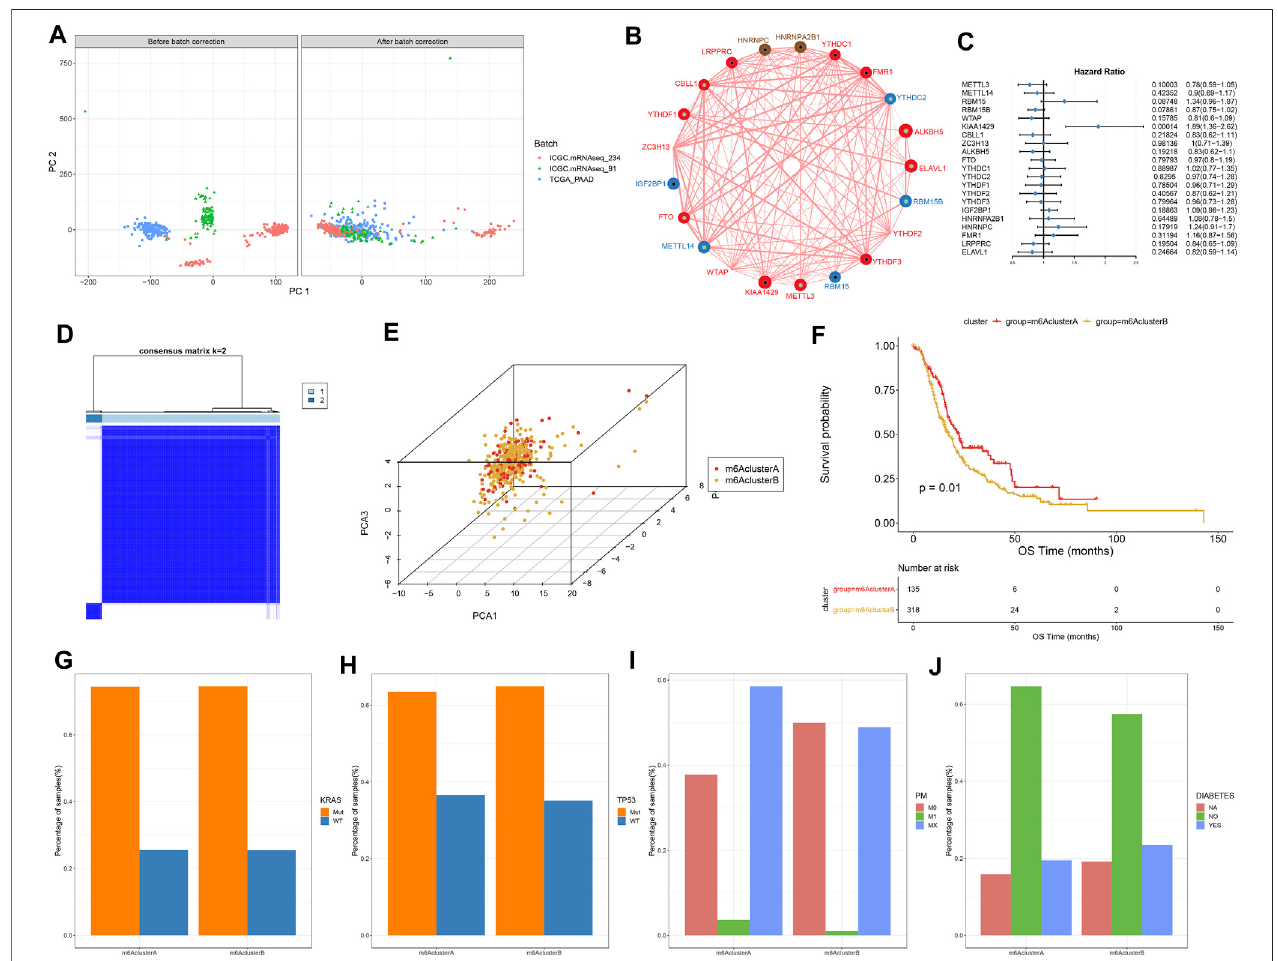
FIGURE 2 | Construction of two m 6 A methylation modi fi cation patterns in pancreatic cancer from TCGA and ICGC datasets. (A) PCA plots showing before and after batch correction ofTCGAand ICGC datasets. (B) An interaction networkof m 6 Aregulators. The sizeofthe circle indicates the impactof each regulatoronsurvival, andthelargerthecircle,themorerelevantitsexpressionistotheprognosis.Thegreendotinthecircleindicatesthattheregulatorisaprotectivefactorforprognosis,and the black dot in the circle indicates that the regulator is a risk factor for prognosis. The lines connecting regulators indicate their interactions, negative correlations are marked in blue, and positive correlations are marked in red. (C) Multivariate cox regression analyses for assessing associations of m 6 A regulators with pancreatic cancerprognoses. (D) Consensusmatrixheatmapwhen k (cid:1) 2. (E) PCA plotsshowingthedifferencesbetweenm 6 AclusterAandBbasedontheexpression pro fi lingof m 6 Aregulators. (F) Kaplan-Meiercurvesoftwom 6 Aclusters.Pwasdeterminedwithlog-ranktest.Distributionsof (G) KRASmutation, (H) TP53mutation, (I) metastasis, and (J) diabetes in two m 6 A